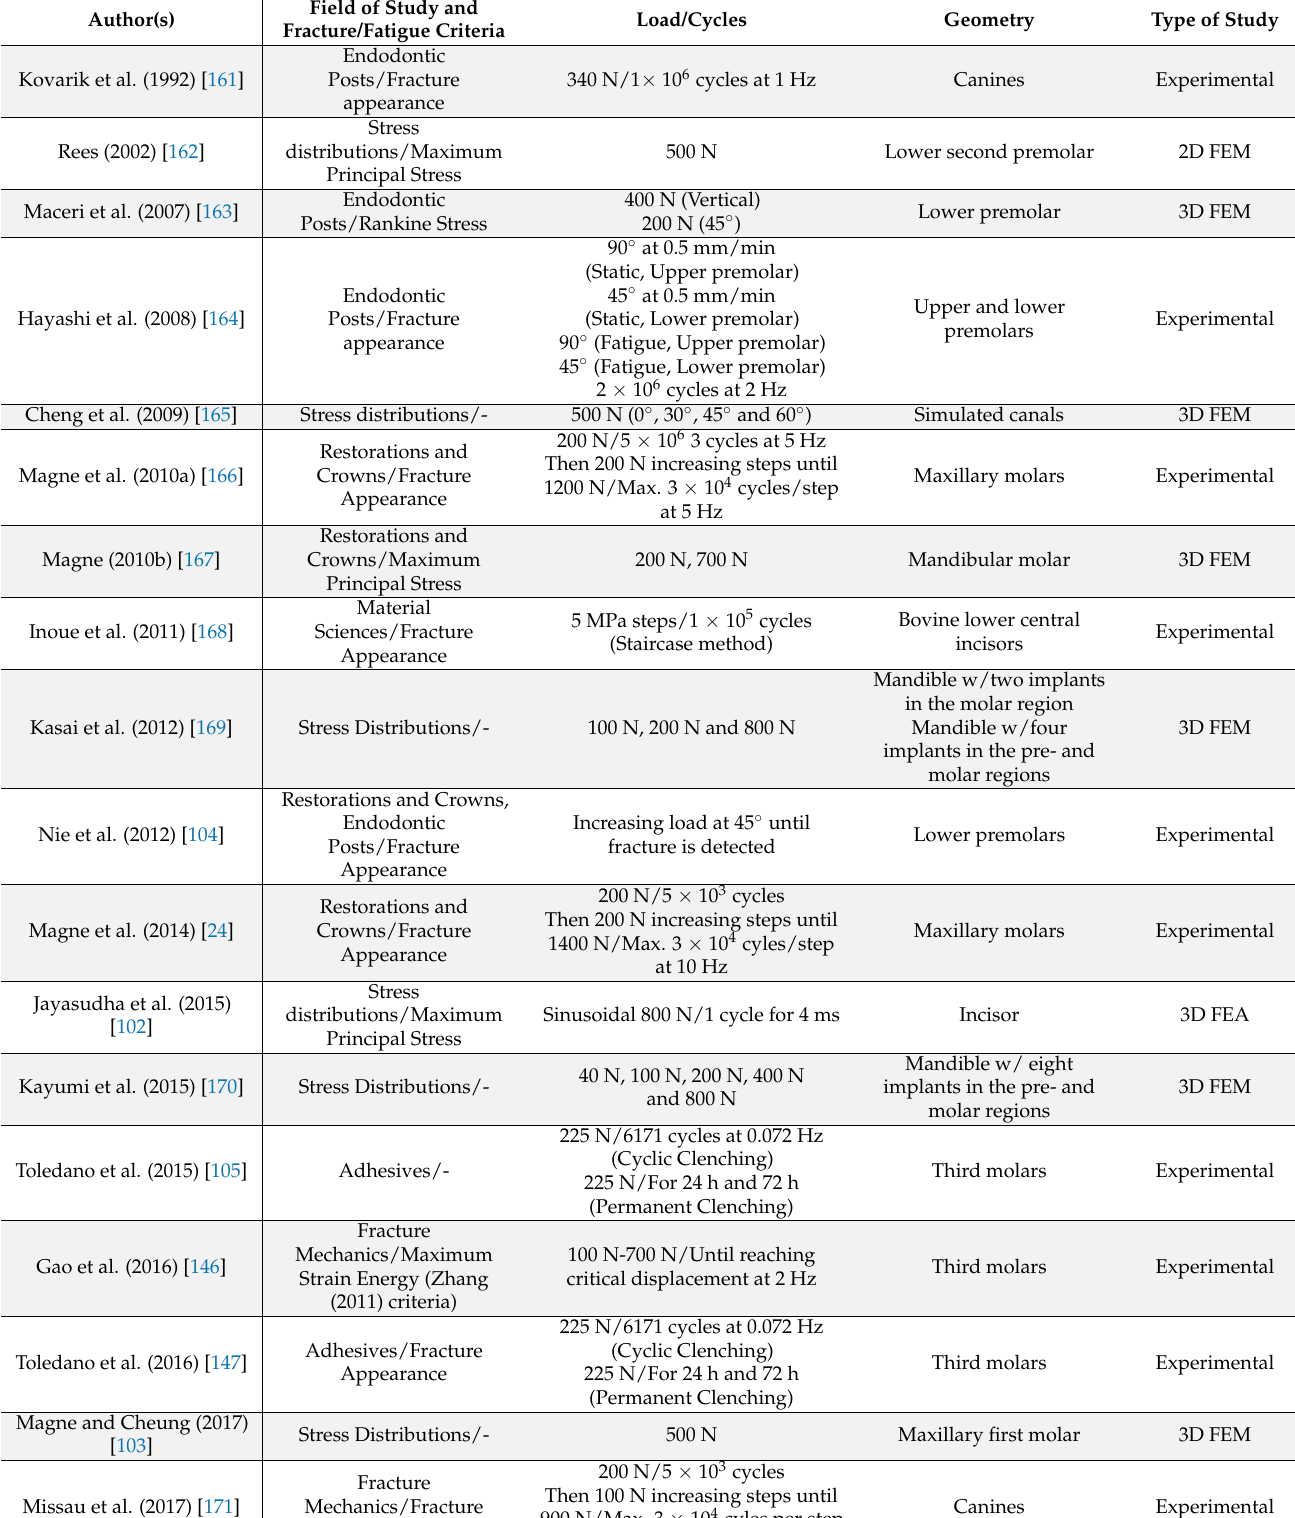
Table 7. Summary of experimental and FEM studies on clenching